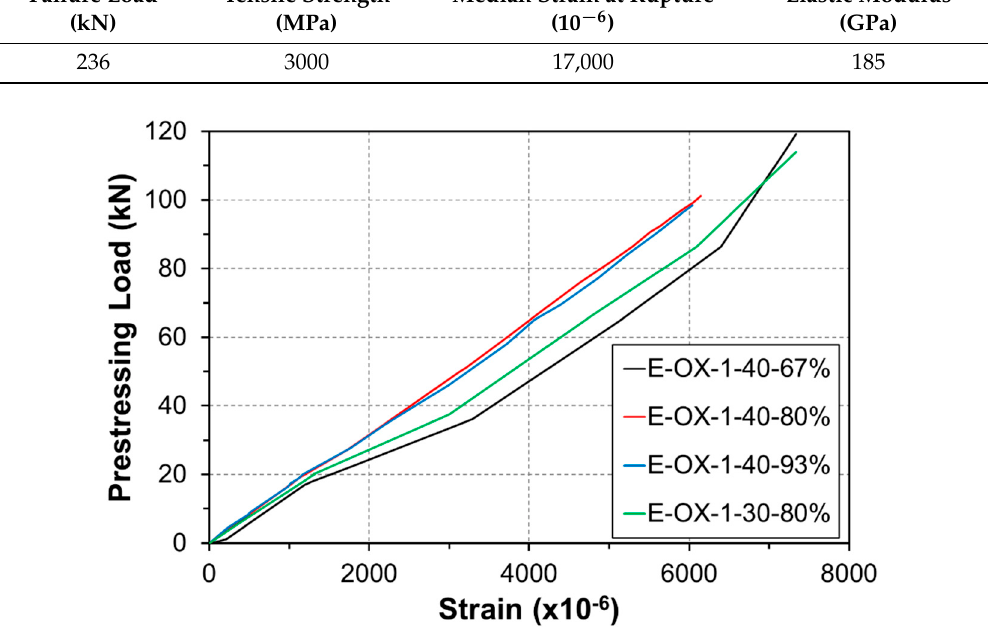
Figure 4. CFRP prestressing load wrt stress-strain curve.